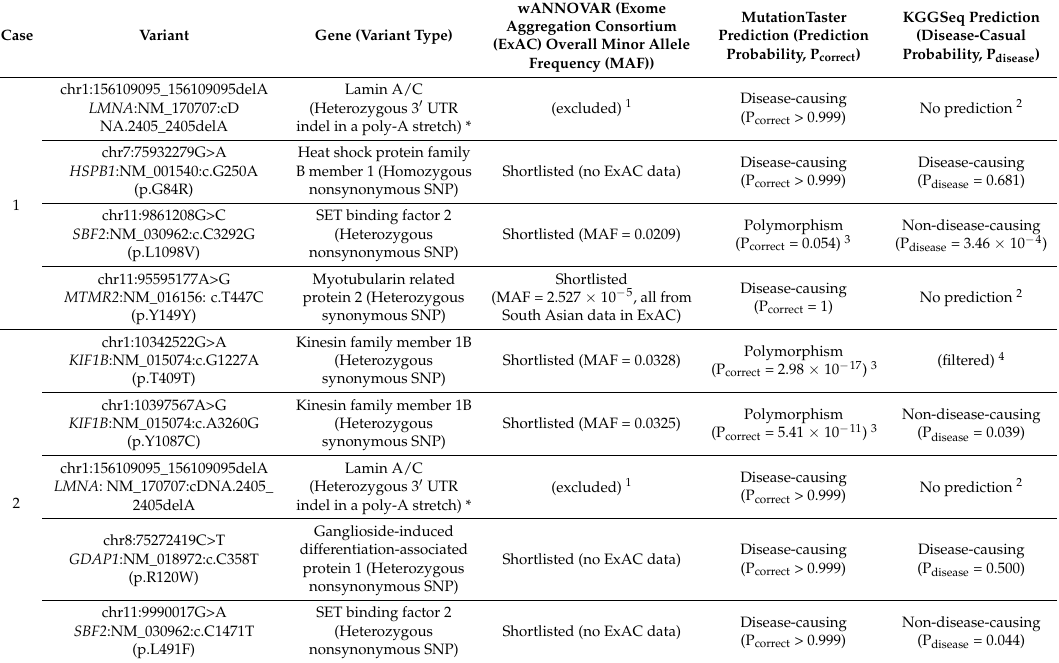
Table 2. Exonic and splice-site variants shortlisted using wANNOVAR and analysed by MutationTaster and